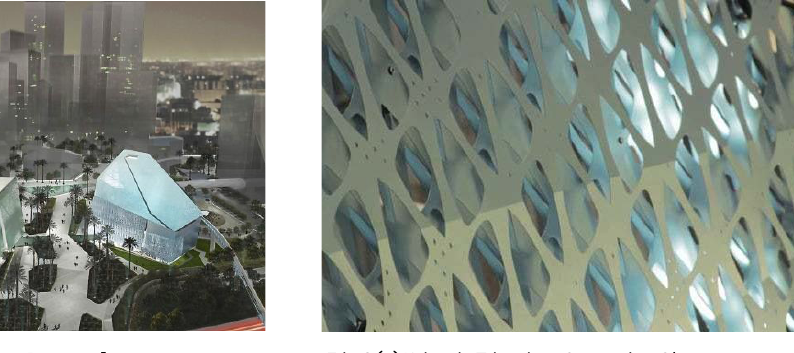
Fig 8(c) Kinetic Titanium Screening Sheets